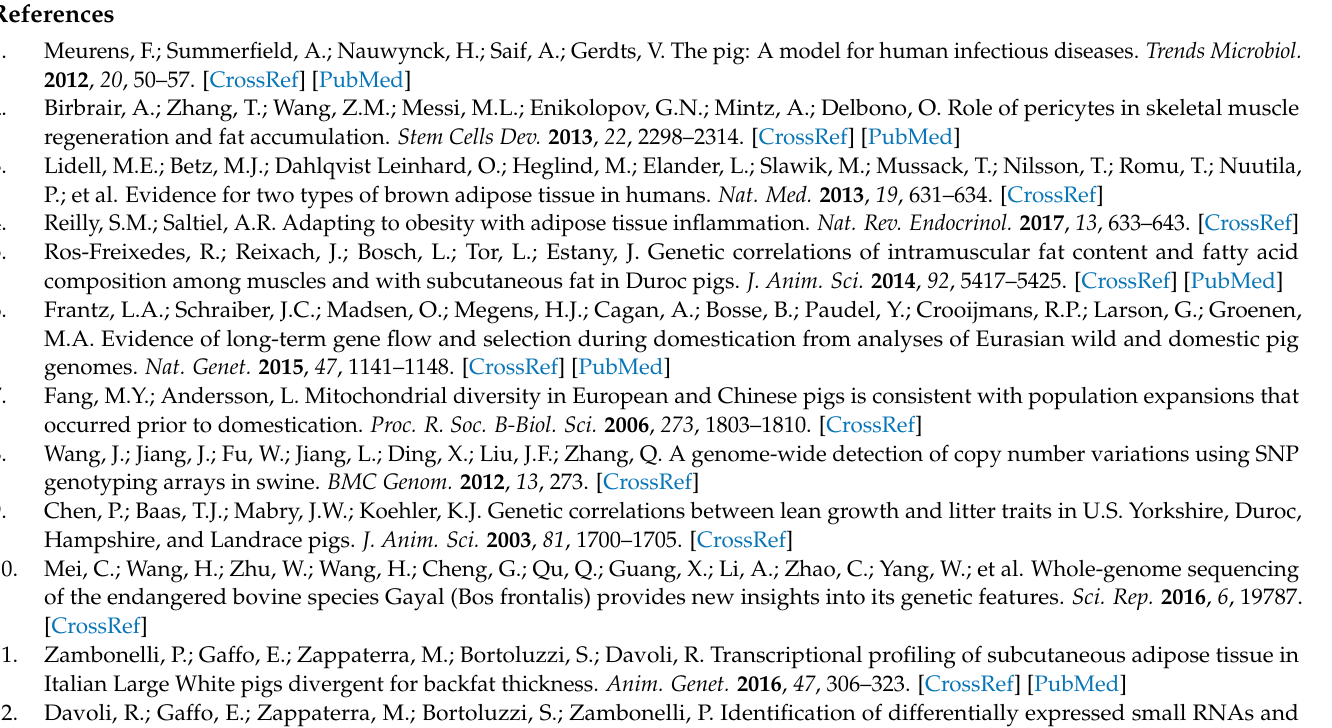
Table S2: The identified circRNAs, Table S3: The circRNAs from four datasets, Table S4: The DECs be- tween and within Landrace and Tongcheng pigs, Table S5: The target miRNAs of sus_intergenic_001702 and